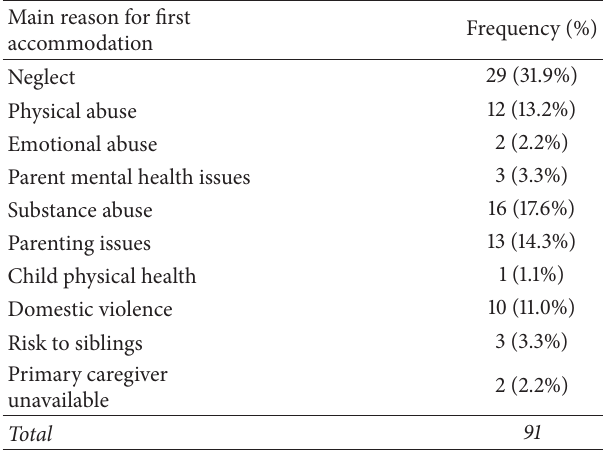
Figure 1: Number of carers per child (updated to 1 December 2013) ( 𝑛 = 91 ). Table 1: Main reason reported for accommodation at first episode of care ( 𝑛 = 91 ).